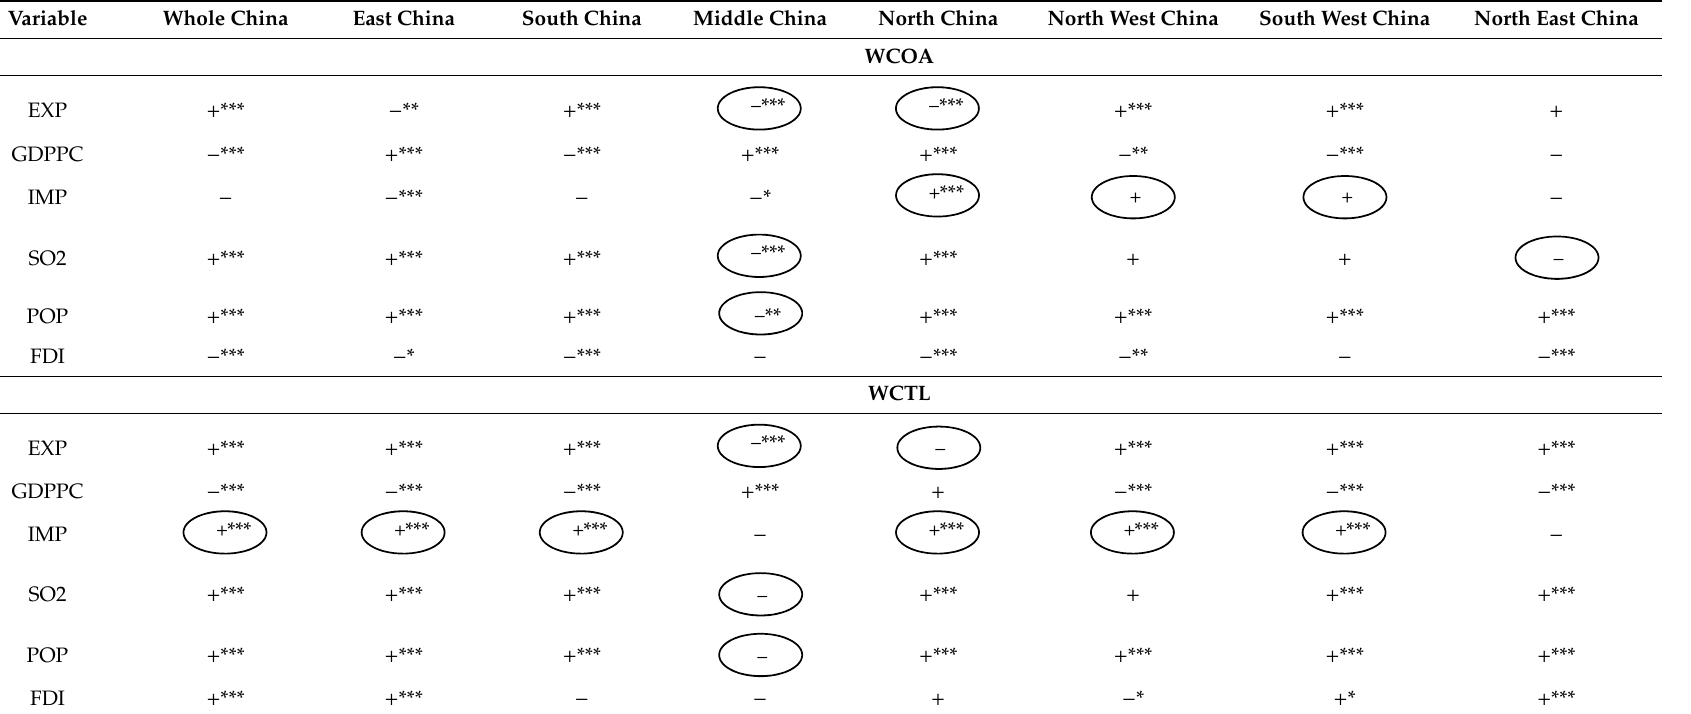
Table 8. FMOLS (Fully modified ordinary least squares) estimates and the sign comparison—actual signs.